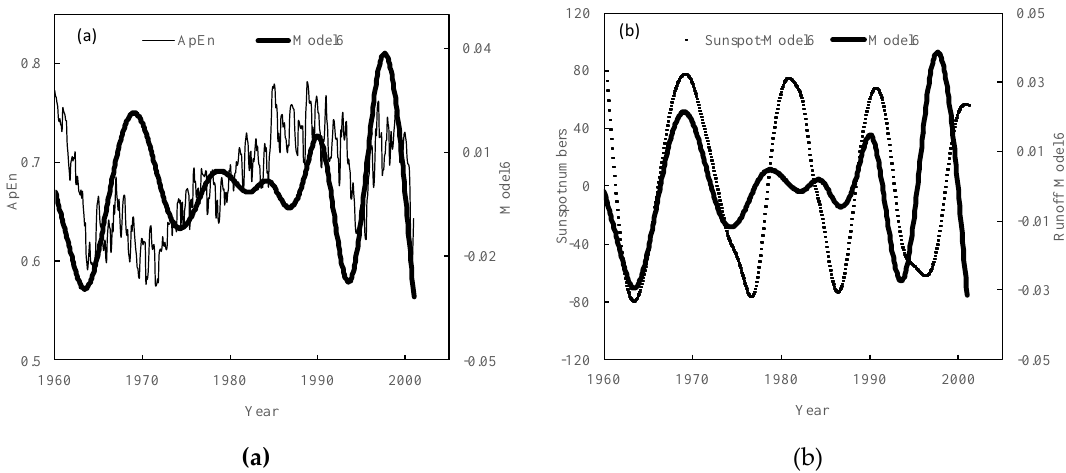
Figure 11. The comparisons between the runoff ApEn and IMF-6 component ( a ) as well as between the IMF-6 component of sunspot numbers and IMF-6 component of runoff ( b ).